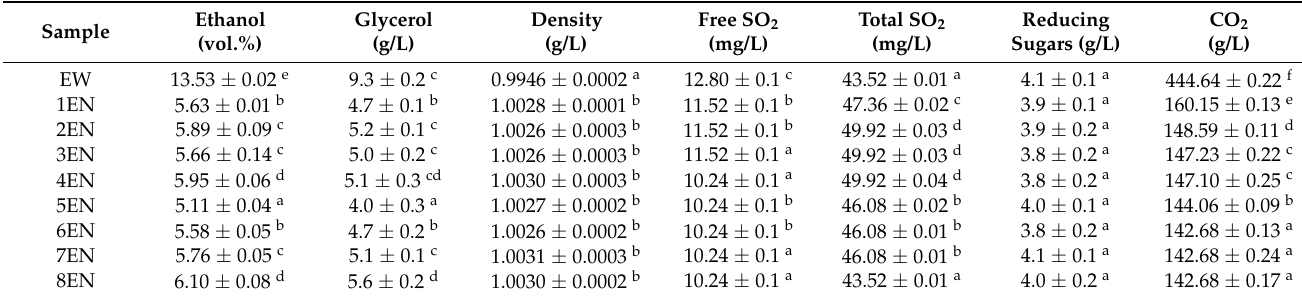
Table 6. Chemical composition of initial ecological Cabernet Sauvignon wine and nanofiltration retentates at 2.5, 3.5, 4.5 and 5.5 MPa with cooling and without cooling. Different superscript letters (a, b, c, d, e, f) in the same column represent statistically different values ( p < 0.05; ANOVA, Fisher’s (LSD)